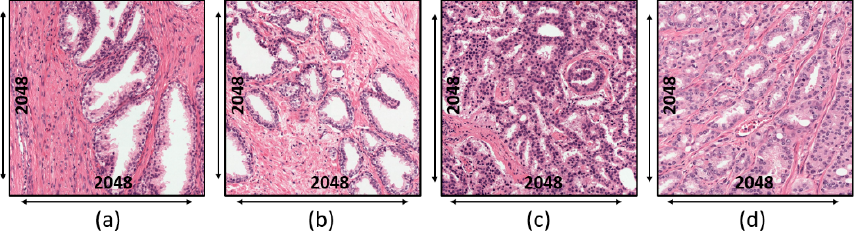
Figure 3. Microscopic biopsy images of an external test set at the magnification factor of 10×. ( a , b )